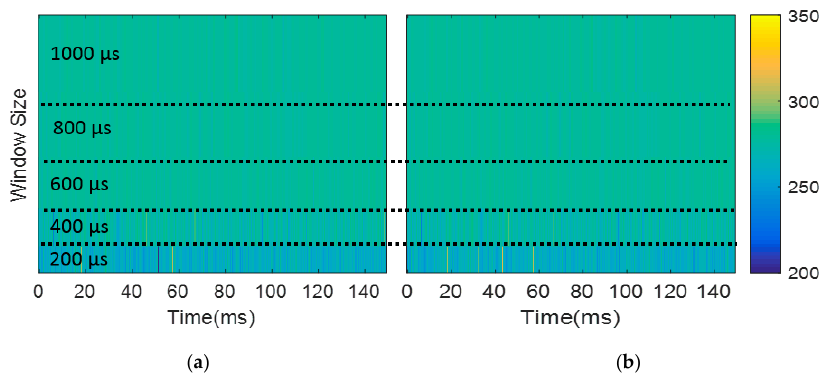
Figure 14. The spectra of peak frequency (unit: kHz), ( a ) embedded streamed signal ( SNR = 1.0), and ( b ) original streamed signal.